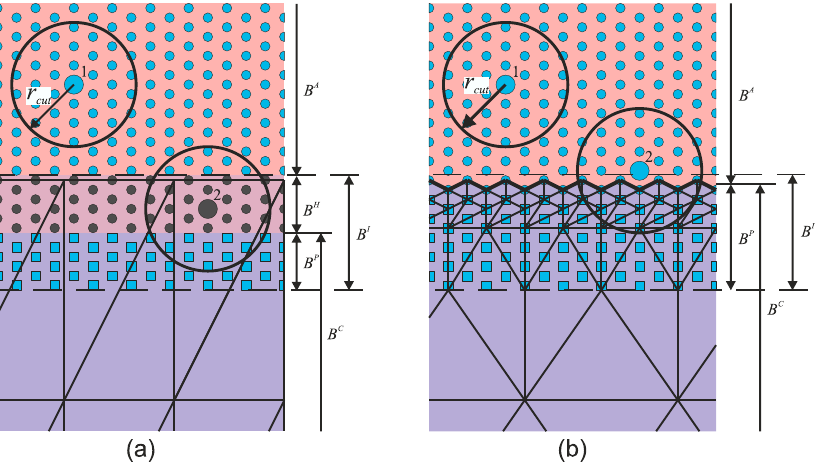
Figure 12. Schematic representation of generic interfaces used in coupled atomistic/continuum simulations: ( a ) with the handshake region; and ( b ) without the handshake region. Atom 1 does not influence the continuum directly (while atom 2 does) because of the finite cutoff length. Padding, handshake, and regular atoms are depicted by blue squares, black circles, and blue circles, respectively.